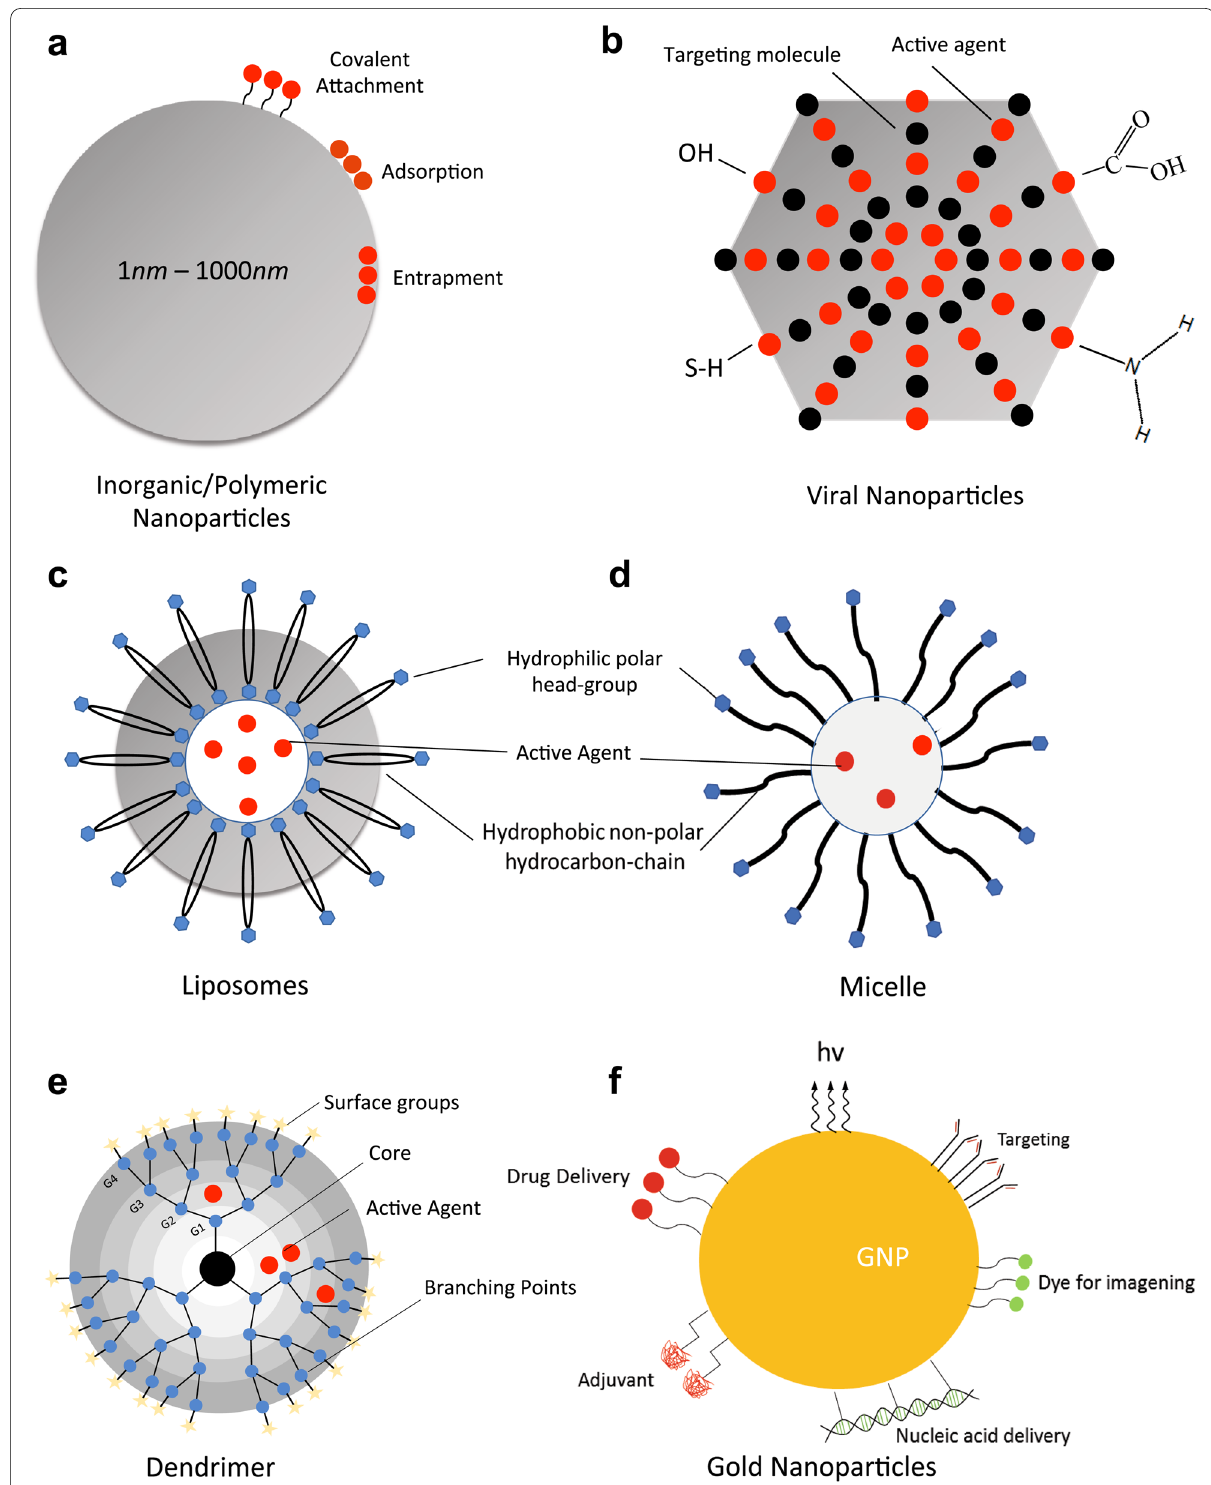
Fig. 1 Nanoparticle